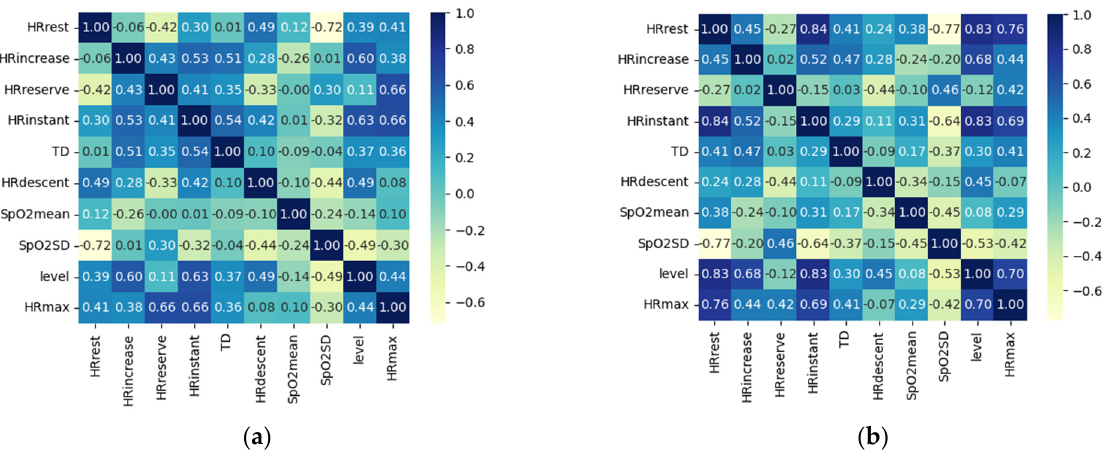
Figure 5. PCC among all features. ( a ) PCC among features extracted from boys’ recordings; ( b ) PCC among features extracted from girls’ recordings.